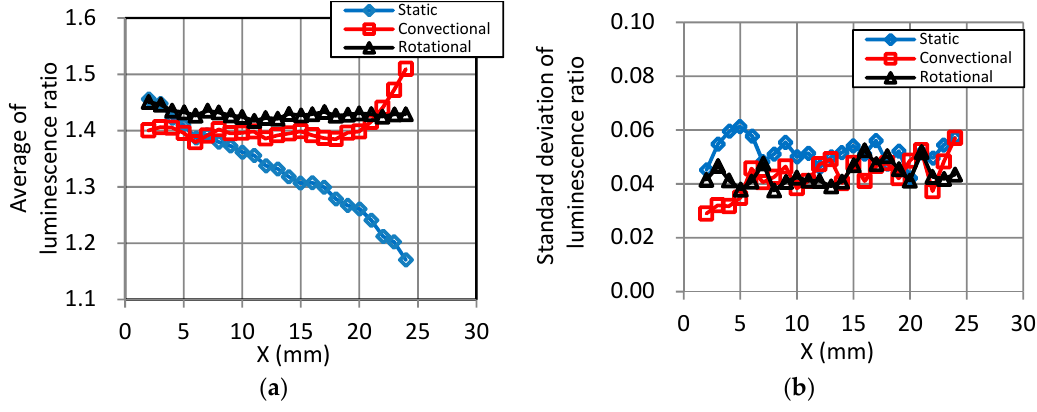
Figure 9. Statistical plots of luminescence ratios along the X -axis. ( a ) Average; ( b ) Standard deviation.